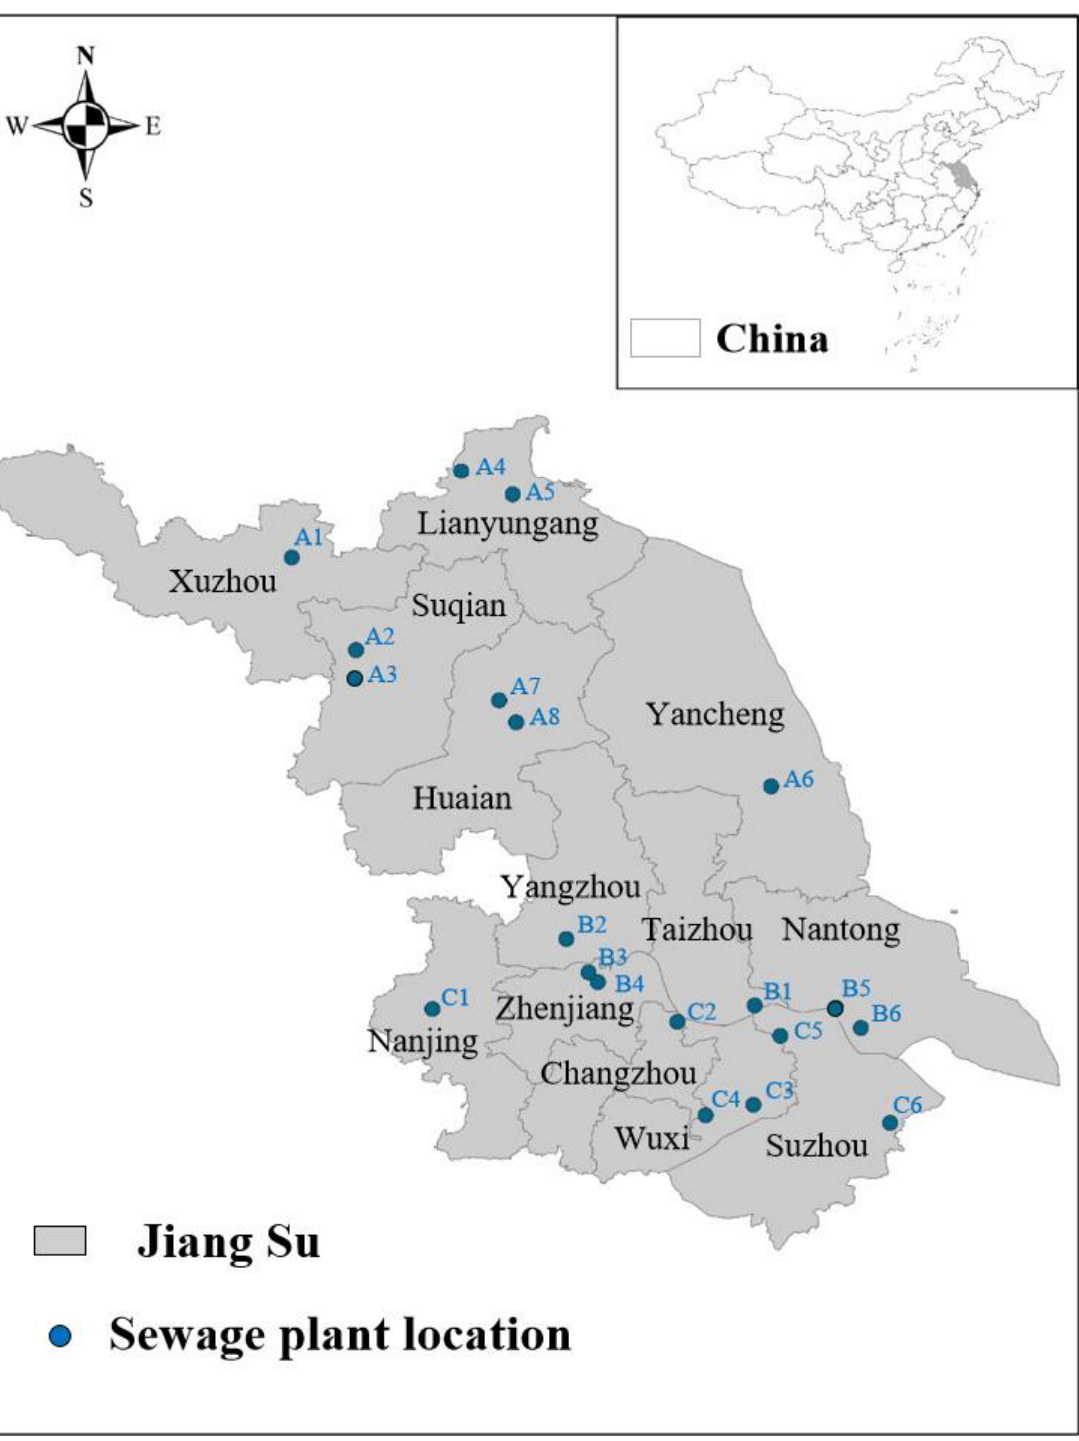
Figure 1. Distribution of different wastewater treatment plants.